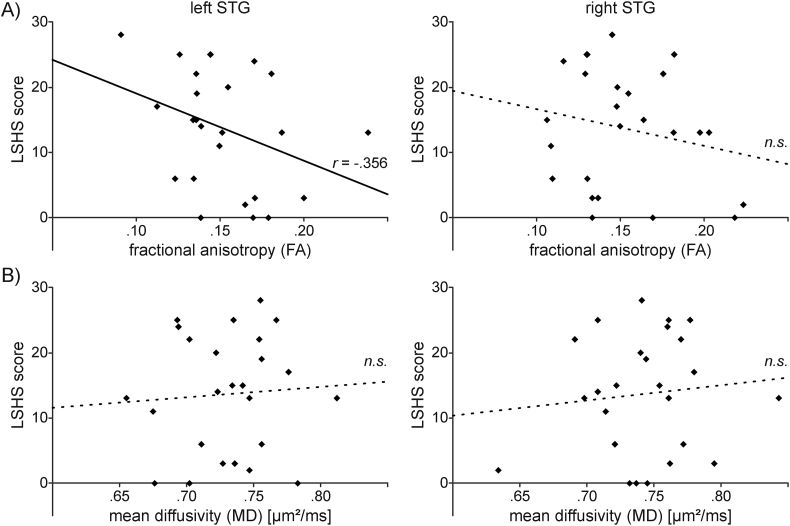
Relationship between DTI-based measures of microstructure and hallucination proneness. The scatter plots show scores of hallucination proneness (LSHS) as a function of A) fractional anisotropy (FA) and B) mean diffusivity (MD) of the left and right superior temporal gyrus (STG), respectively. FA values (but not MD) in the left STG (but not the right STG) showed a significant correlation with LSHS scores. Relationships that were significant (p < .05) in the multiple regression (see text) are indicated by sold lines and the partial correlation coefficient (r), non-significant (n.s.) by dashed regression lines. n = 25.